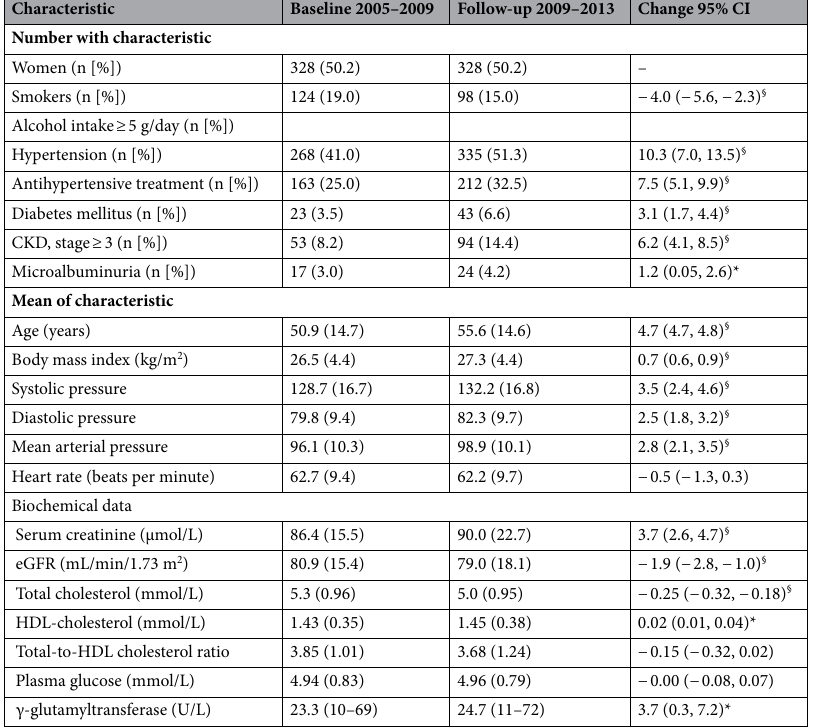
Table 4. Baseline and follow-up characteristics of 653 participants. CKD, chronic kidney disease; eGFR, estimated glomerular filtration rate derived from serum creatinine by the CKD-EPI formula; HDL, high- density lipoprotein. Blood pressure was the average of five consecutive auscultatory readings. Hypertension was a blood pressure of ≥ 140 mm Hg systolic or ≥ 90 mm Hg diastolic, or use of antihypertensive drugs. Diabetes mellitus was a fasting plasma glucose of > 7.0 mmol/L (> 126 mg/dL) or use of antidiabetic agents. The assessment of microalbuminuria (> 3.5/> 2.5 mg per mmol creatinine in women/men) was available in 566 participants. The central tendency (data spread) is given as arithmetic mean (SD) or median (5th-5th percentile interval). For categorical variables, percentage change is given. Significance of the change from baseline to follow-up (95% confidence interval): * P ≤ 0.05; † P ≤ 0.01; ‡ P < 0.001; § P ≤ 0.0001.